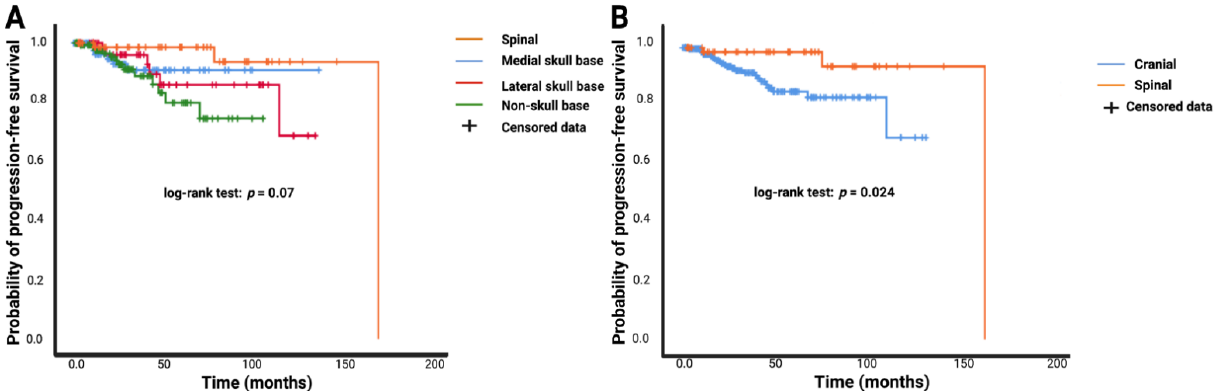
Figure 6. Kaplan – Meier curves of progression-free survival stratified by anatomic meningioma location. ( A ) Comparison of spinal (orange line), medial skull base (blue line), lateral skull base (red line), and non-skull base (green line). ( B ) Kaplan – Meier analysis of probability of time to meningioma progression stratified by cranial (blue line) versus spinal (orange line) meningioma. Censored data (= progression-free at last clinical examination) are represented by vertical dashes within all progression-free survival curves. The time axis is right-censored at 200 months. p -values of the log-rank test are reported.